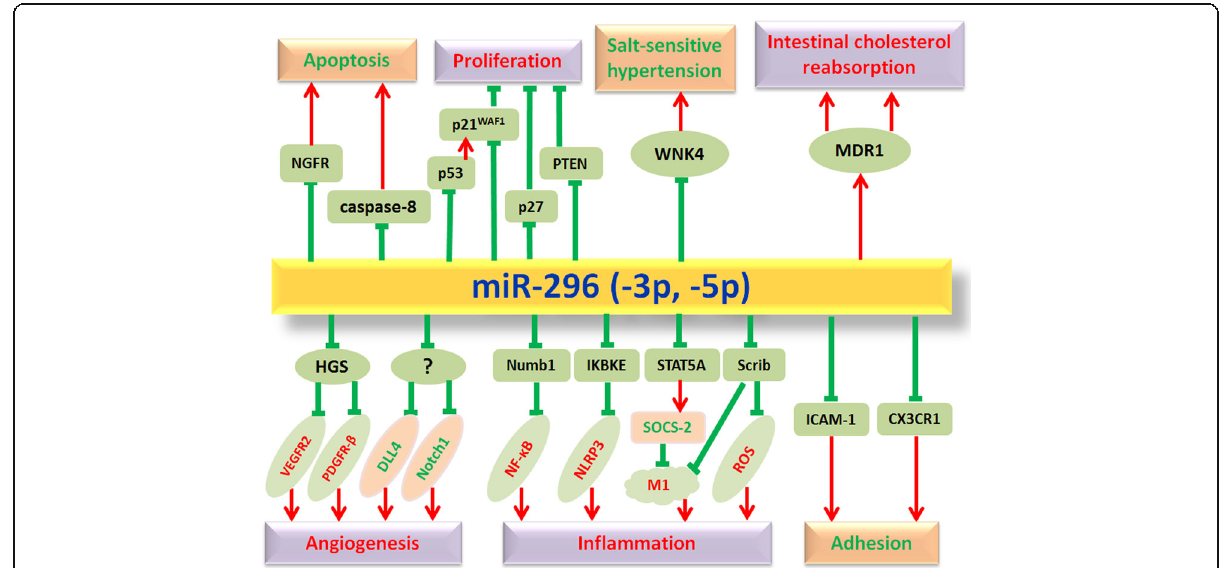
Fig. 2 The roles of miR-296 and their target genes in atherosclerosis. MiR-296 promotes angiogenesis via reducing the levels of HGS and then elevating VEGFR2 and PDGFR- β , and simultaneously reducing the expression levels of DLL4 and Notch1 (the mechanism is not clear). MiR-296 promotes the inflammatory response. MiR-296 targeted inhibition of NumbL and subsequent NF- κ B activation; miR-296 represses IKBKE and then enhances NLRP3 inflammasome; miR-296 inhibits the expression of STAT5A and then represses SOCS-2 and promotes M1 macrophage polarization; miR-296 directly suppresses Scrib and subsequently promotes M1 macrophage polarization and ROS generation, these entire can promote inflammation. MiR- 296 could repress ICAM-1 and CX3CR1 and then inhibit monocyte adhesion. MiR-296 promotes MDR1 expression and subsequent intestinal cholesterol reabsorption. MiR-296 inhibits WNK4 expression and downregulates salt-sensitive hypertension. MiR-296 suppresses p53, p21WAF1, p27 and PTEN expression and then promotes cells proliferation. MiR-296 targeted inhibition of NGFR and caspase-8 promotes cell apoptosis. The black word: Direct target of miR-296, the red word: Expression increased, the green word: Expression